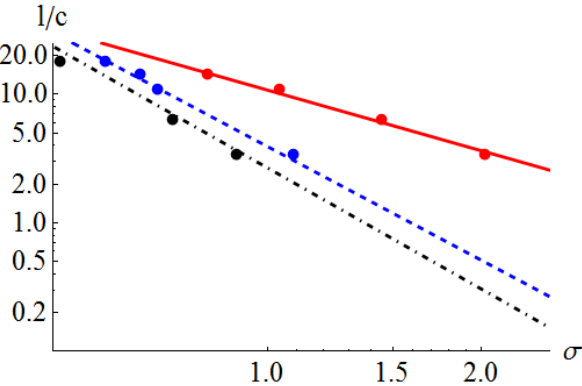
Figure 11. The measured supercavitation bubble dimension ratio vs. the cavitation number for the three cavitators.